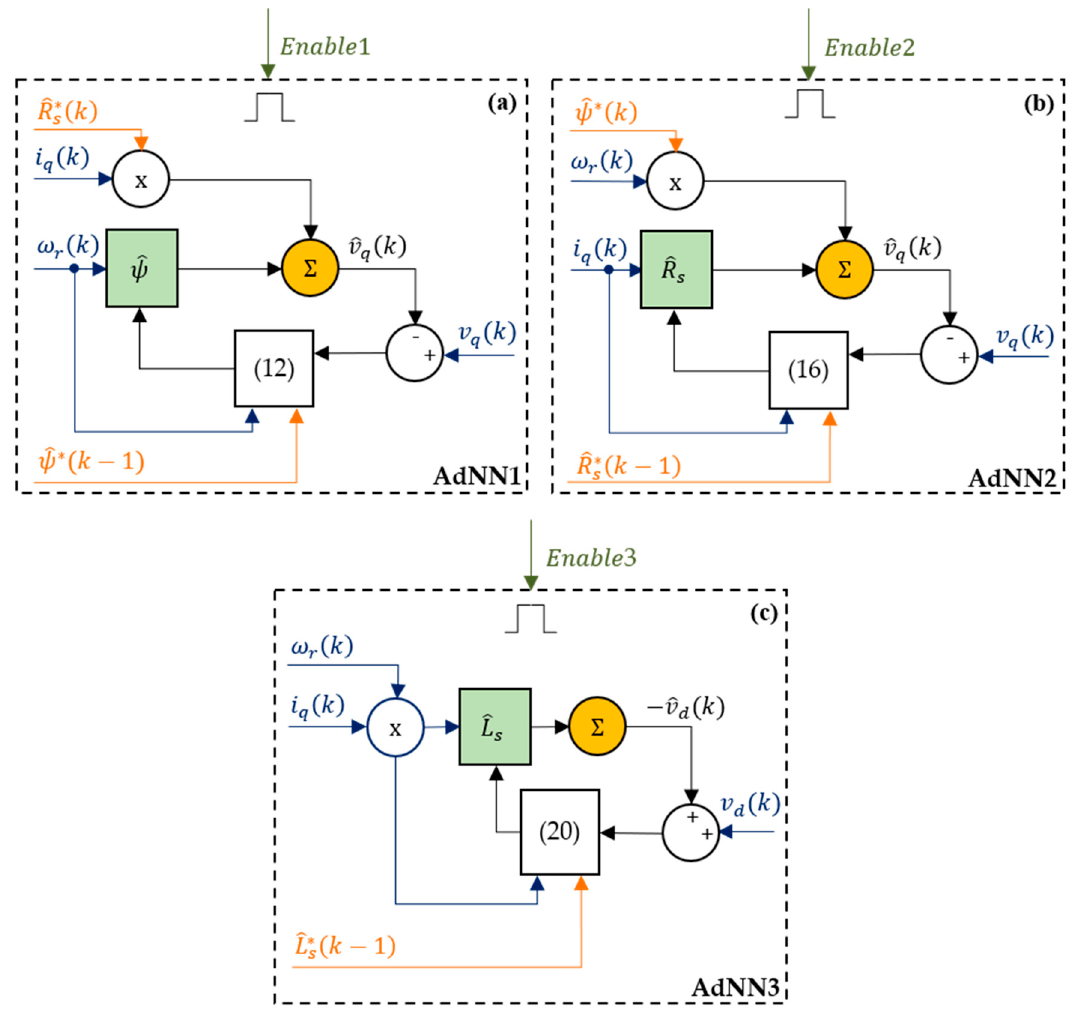
Figure 3. Structures of the Adaline NNs: ( a ) rotor flux linkage estimator; ( b ) stator resistance estimator; ( c ) stator inductance estimator.